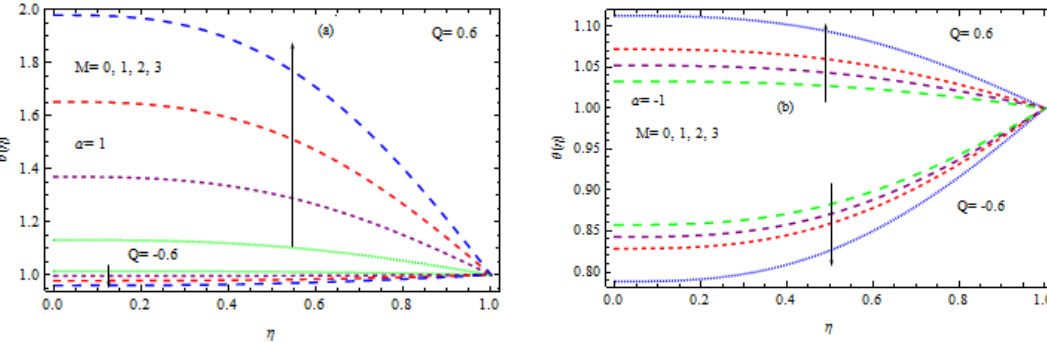
Figure 12. ( a , b ) Influence of 𝑀 on temperature.